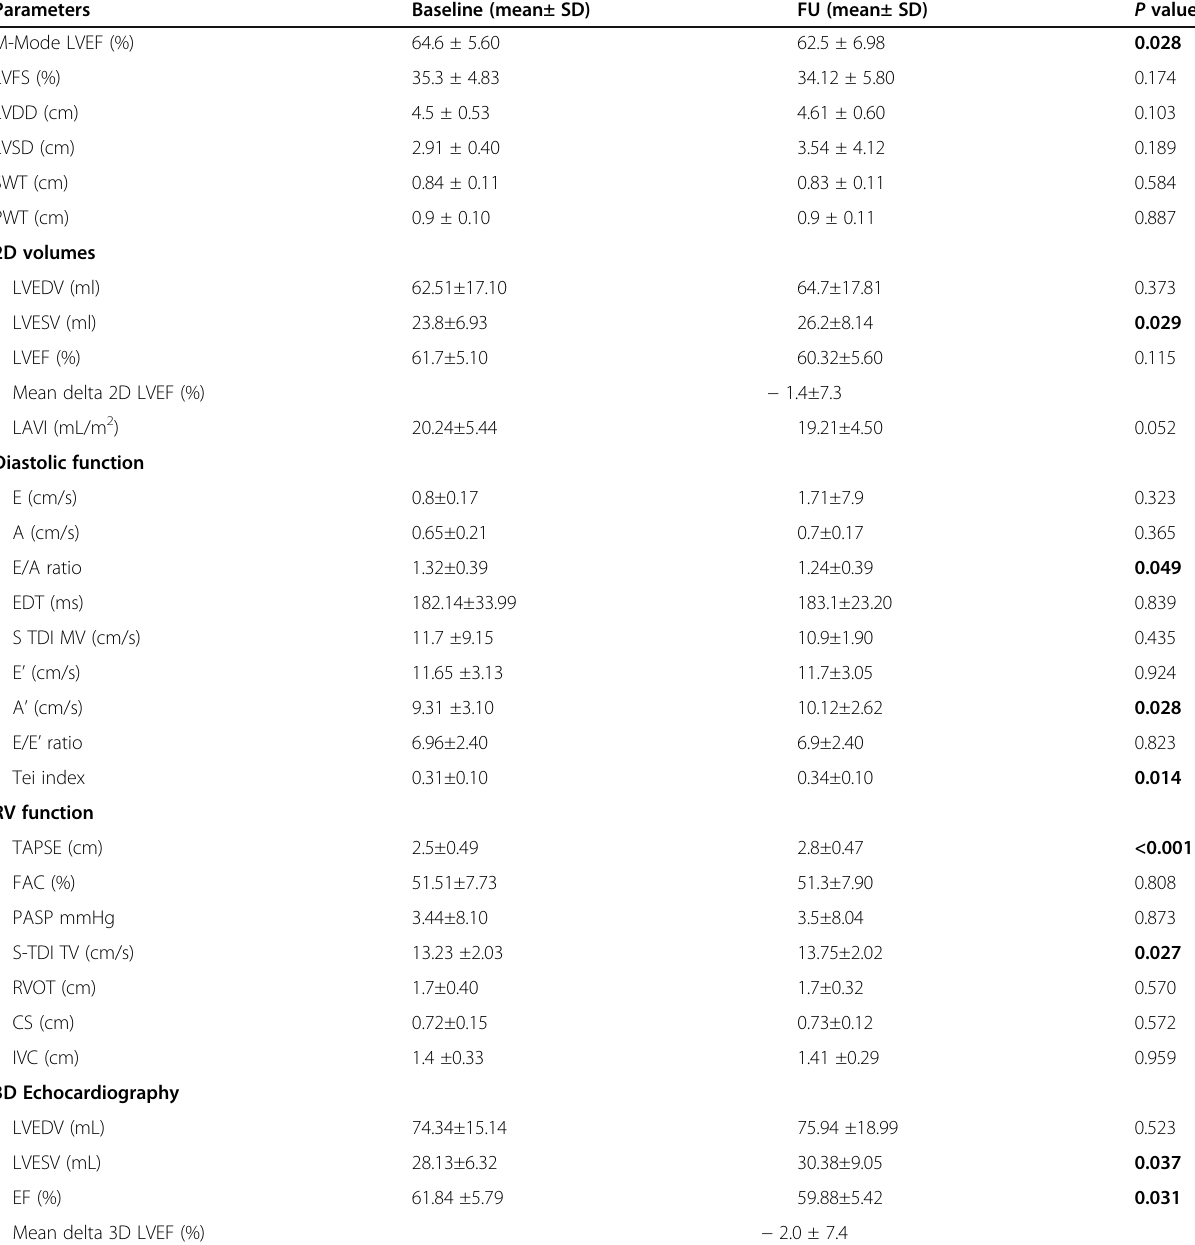
Table 3 Conventional 2D and 3D echocardiographic data of the study patients in the baseline and follow-up visits